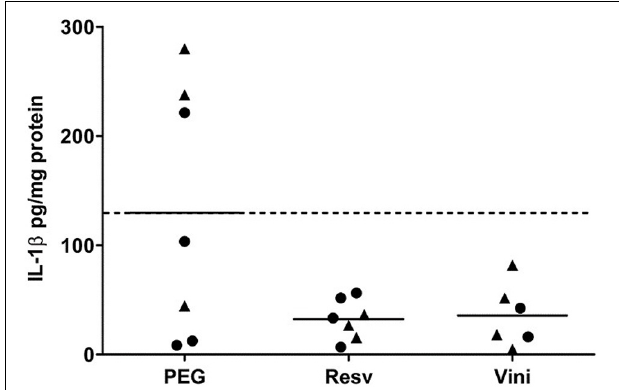
FIGURE 4 | IL-1 β levels in hippocampus after the resveratrol or viniferin treatment. As indicated in section “Materials and Methods,” IL-1 β was quantified by ELISA in hippocampal homogenates of AD mouse brain. Means were represented and expressed in pg/mg protein ( n = 6–7). Kruskal–Wallis test followed by Dunn’s test were used but any significant result was observed. The dotted line represents the mean of the PEG group. Black rounds represent females and black triangles represent